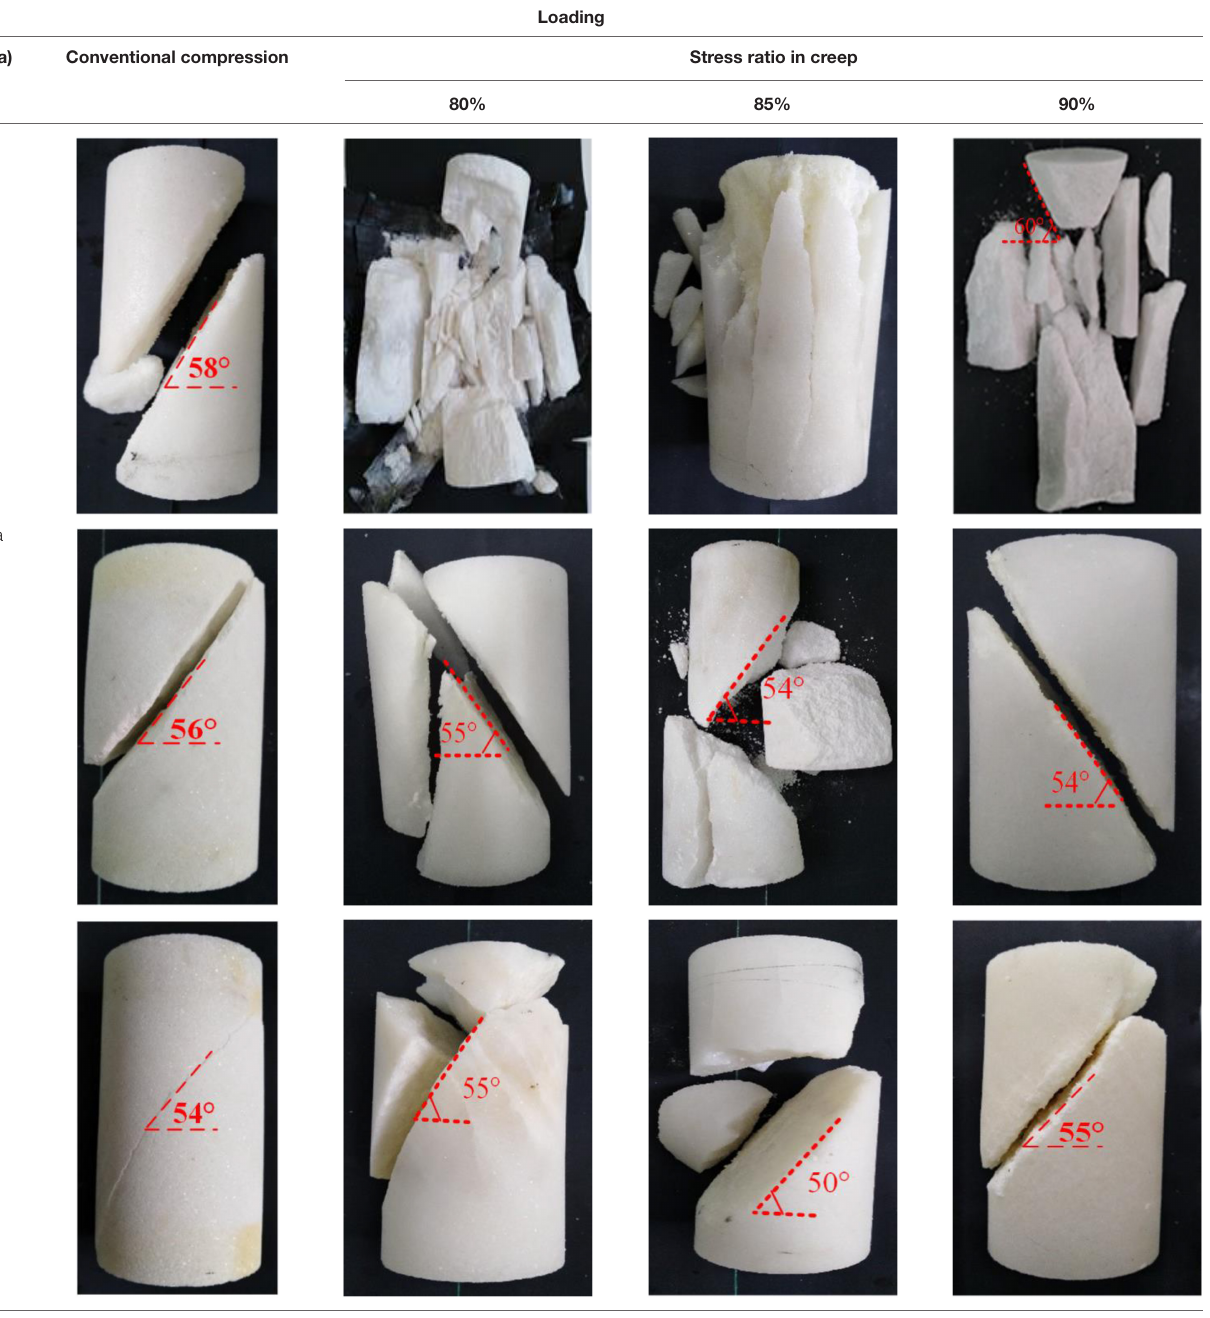
TABLE 2 | Failure characteristics of marble in conventional compression and creep